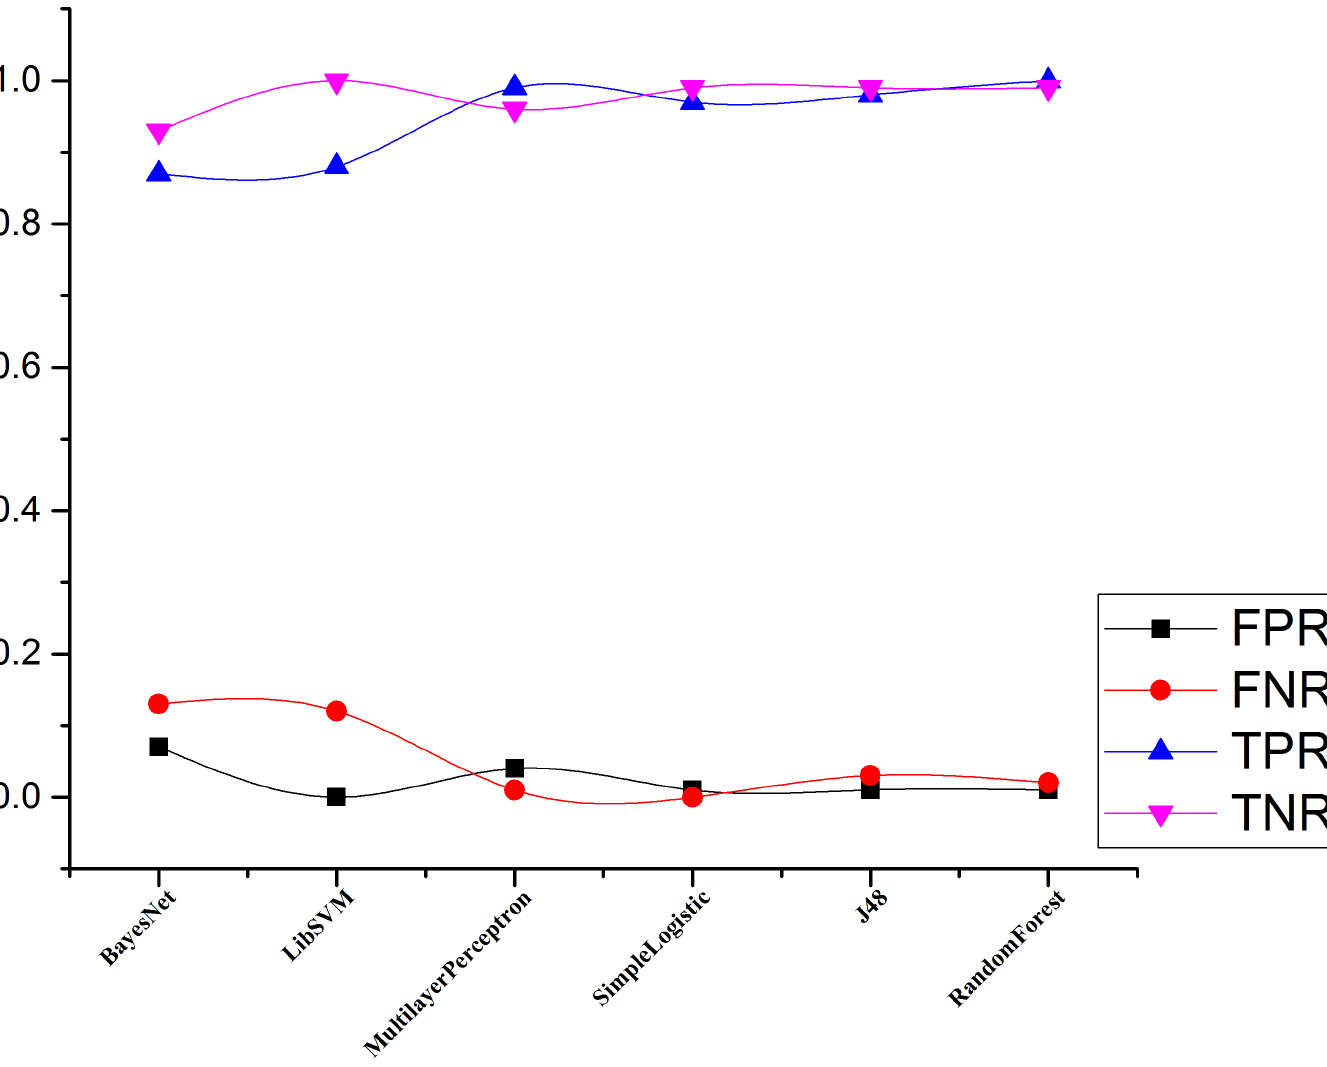
Fig 9. Overall accuracy comparison against each classifier for Drebin